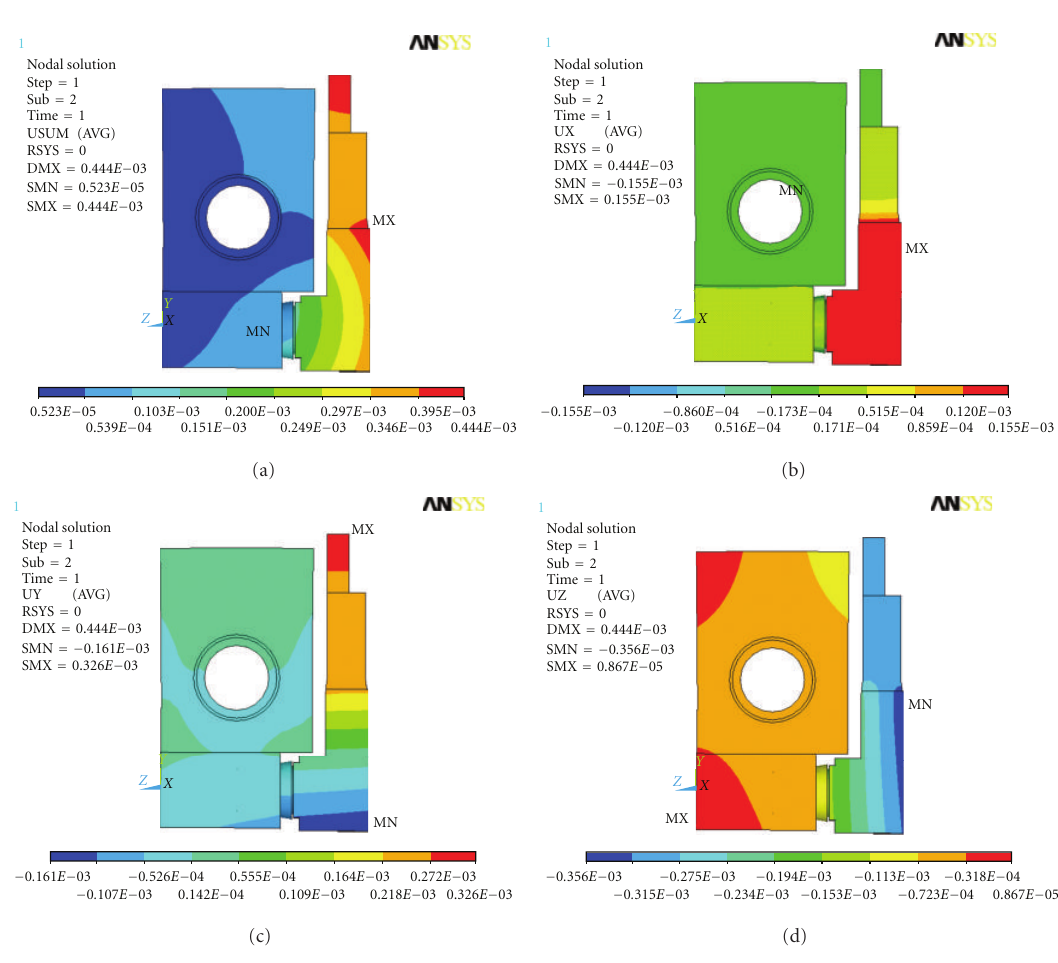
Figure 10: The displacement field at 211 s: (a) global displacement, (b) X -displacement, (c) Y -displacement, and (d) Z